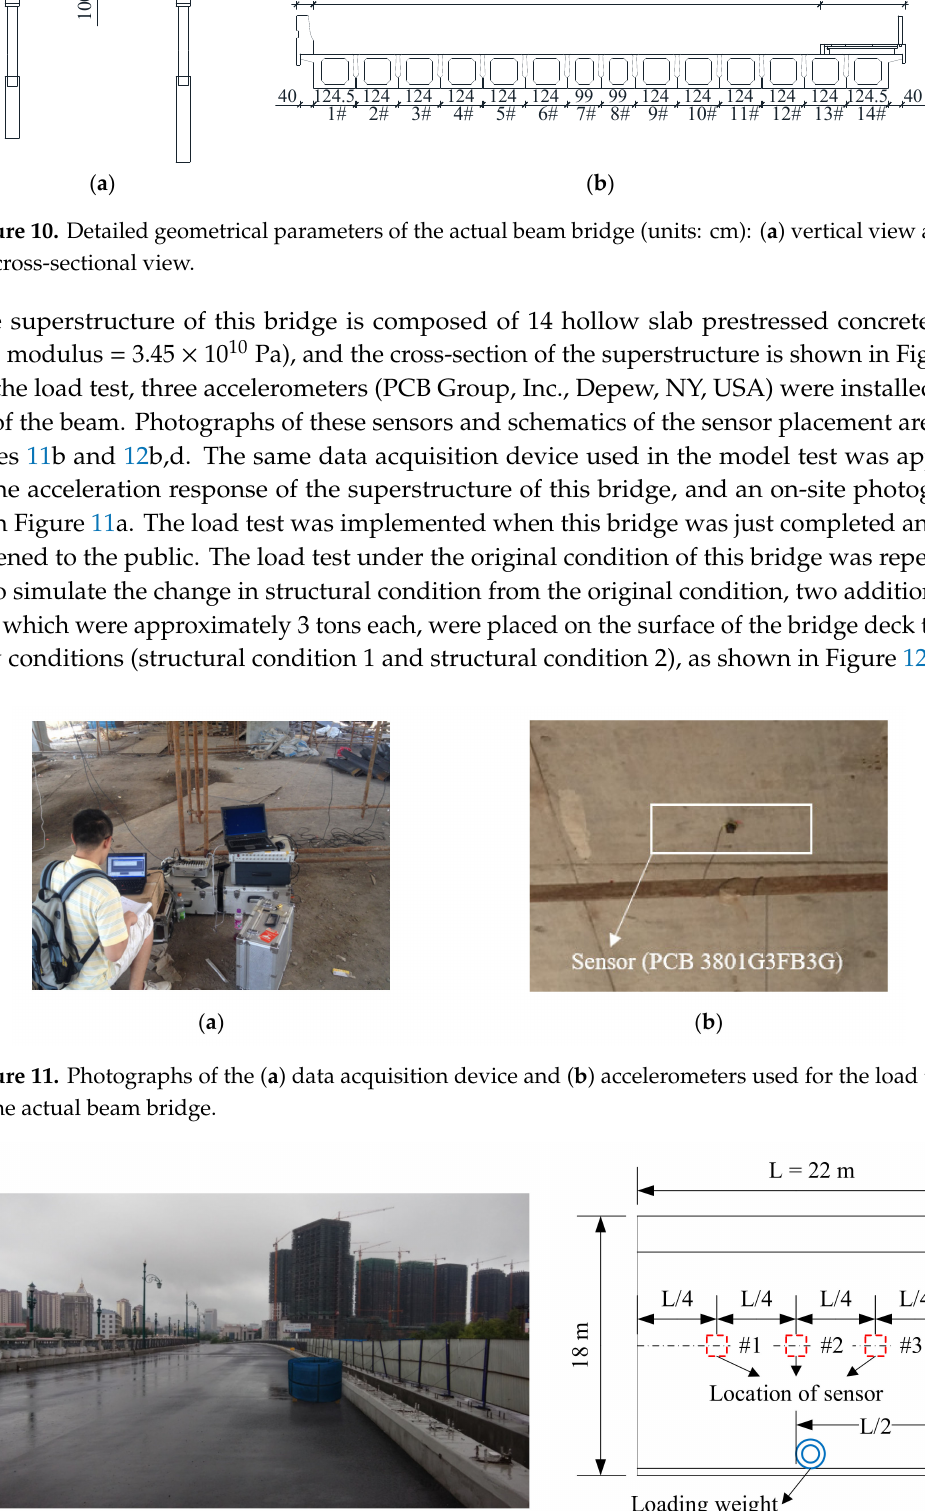
Figure 9. Photograph of the Xinwohong Bridge.